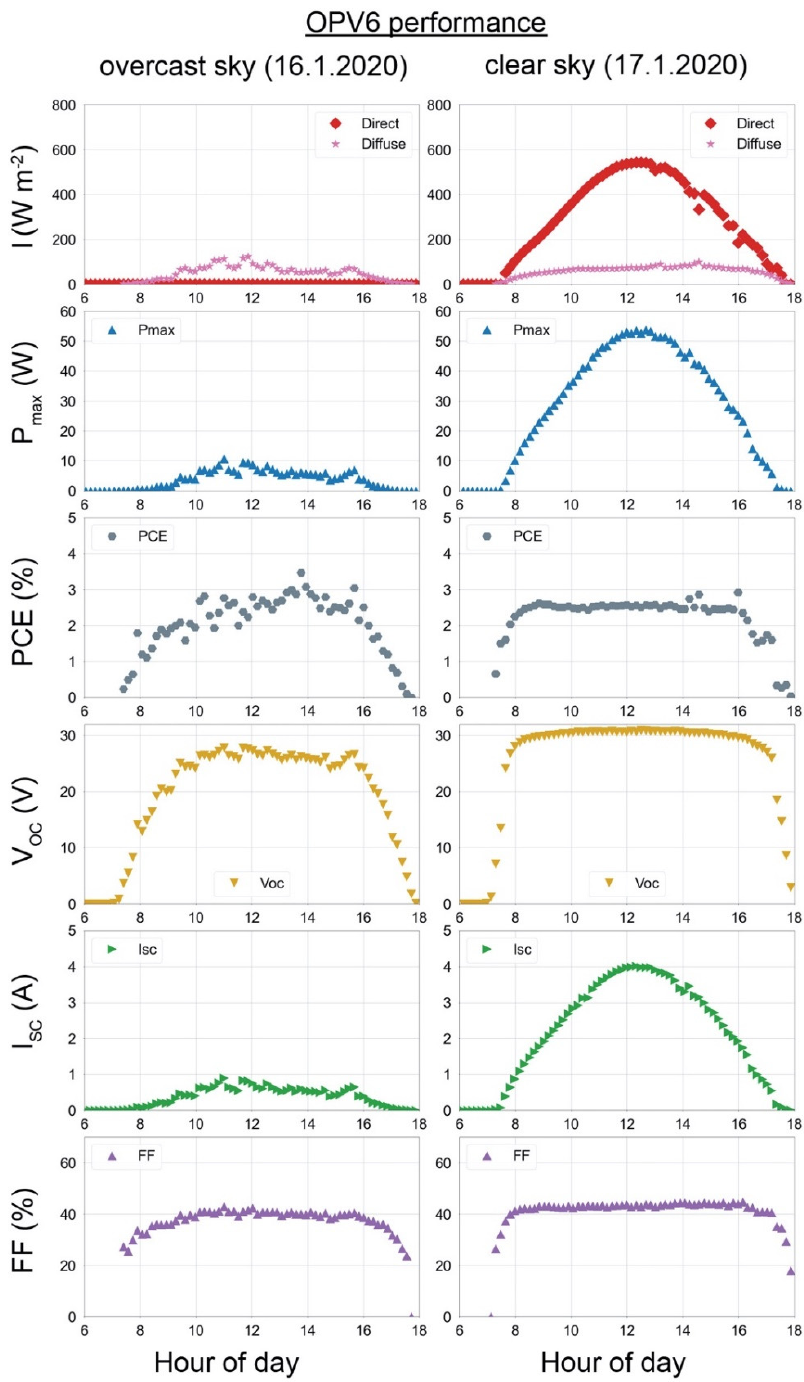
Figure 8. Modeled diurnal direct and diffuse irradiance incident on the OPV6 array with concurrent electrical measurements for completely overcast sky (16 January 2020) shown on the left panel, and clear sky (17 January 2020) shown on the right panel.